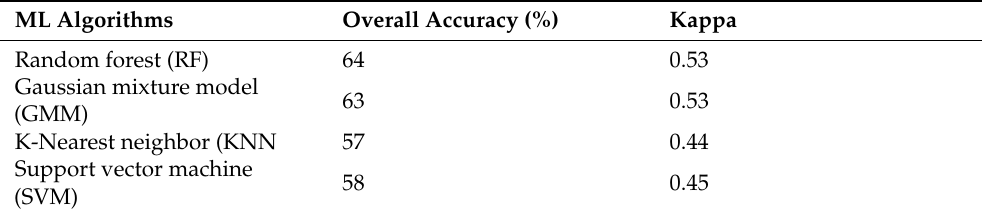
Table 3. Overall accuracy (%) and kappa coefficient values of four different ML algorithms used to classify PlanetScope satellite